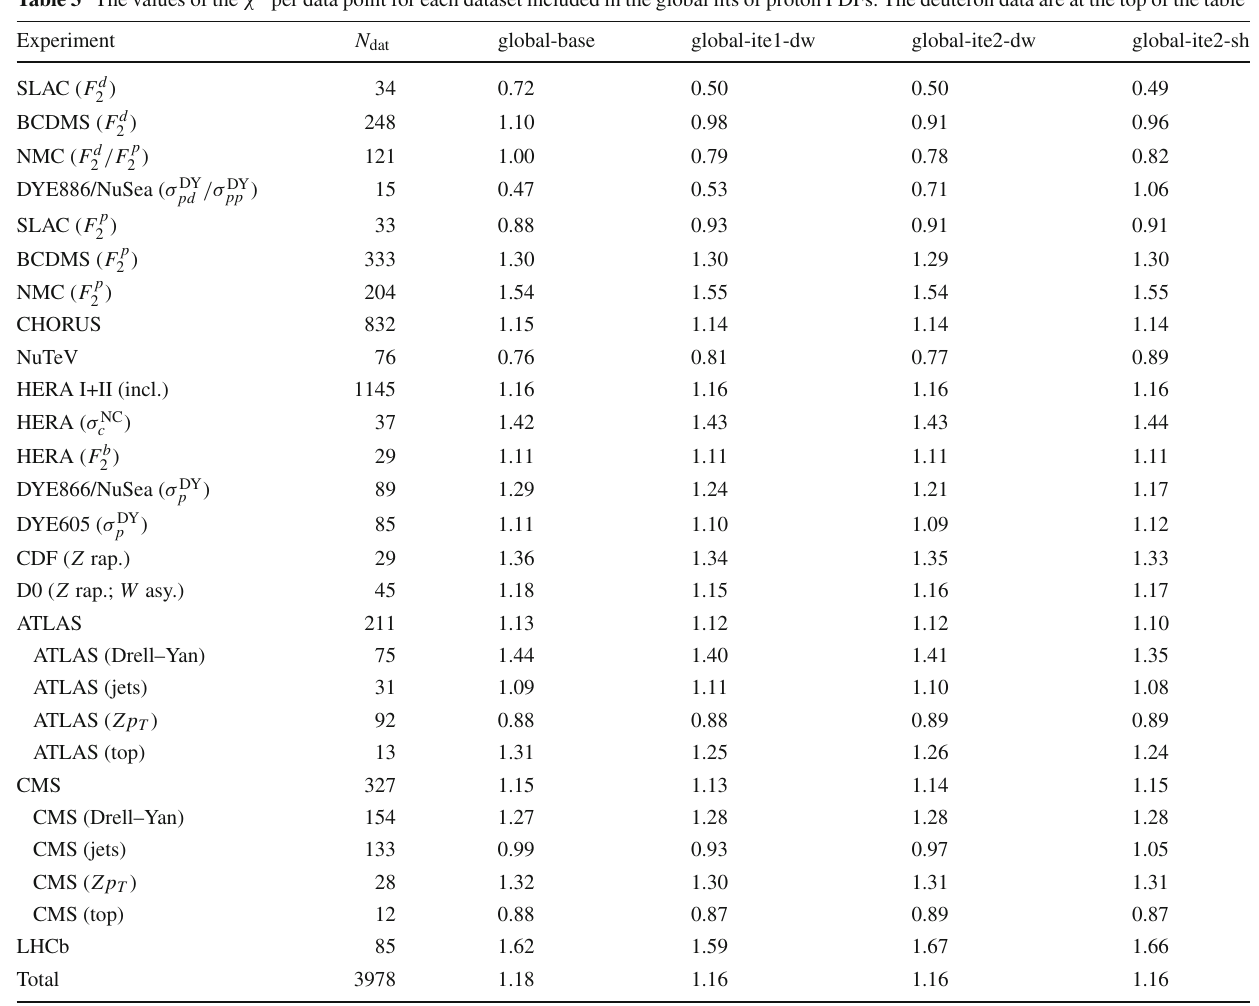
Table 3 The values of the χ 2 per data point for each dataset included in the global fits of proton PDFs. The deuteron data are at the top of the